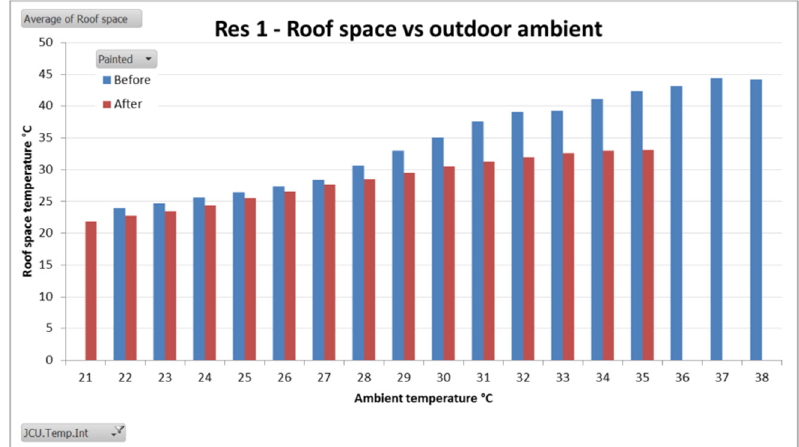
Figure 3. Roof cavity temperature